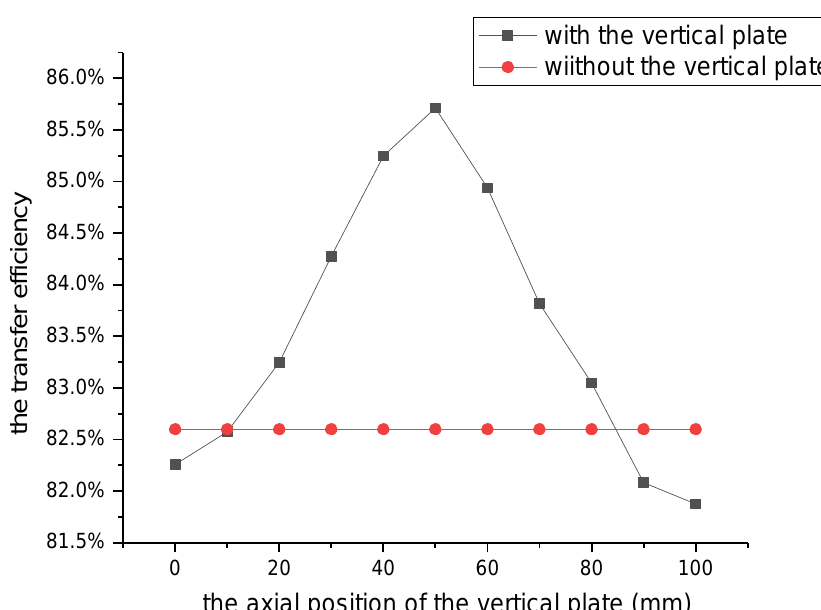
Figure 13. Experimental results of the variation of the efficiency with the axial position of the vertical plates.